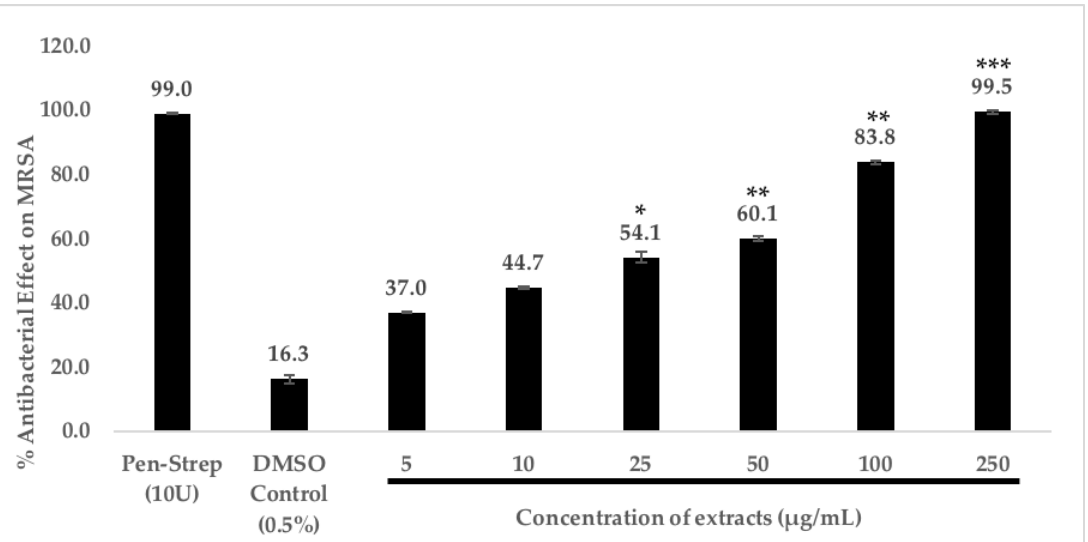
Figure 1. Dose-dependent antibacterial effect of C. racemosa chloroform extracts on MRSA. 1 × 10 6 bacterial cells were incubated with extract at 5 μg/mL, 10 μg/mL, 25 μg/mL, 50 μg/mL, 100 μg/mL, and 250 μg/mL for 2 h at 37 °C. Next, the samples were serially diluted (10 -fold) and plated on Nutrient Agar followed by 18 h of incubation at 37 °C. Finally, bacterial colonies were enumerated